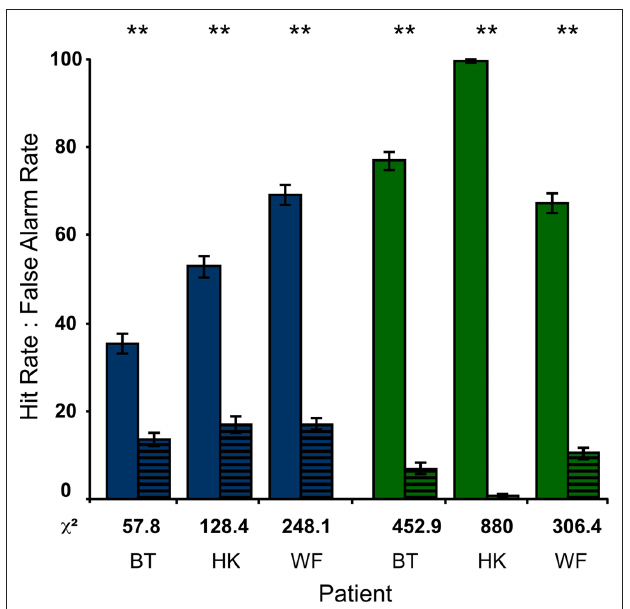
Figure 5 | Detection of disks. When the disks were task-relevant and the letter stream only served to hold fixation, the Hit Rates of all participants were significantly higher than the corresponding False Alarm Rates (striped). This was true for the high-contrast disk in the blind field (blue) as well as for the low-contrast disk in the sighted field (green; P < 0.001 in all cases). As also indicated by the χ 2 -values below each pair of bars, the participants performed better in the sf-lo condition.